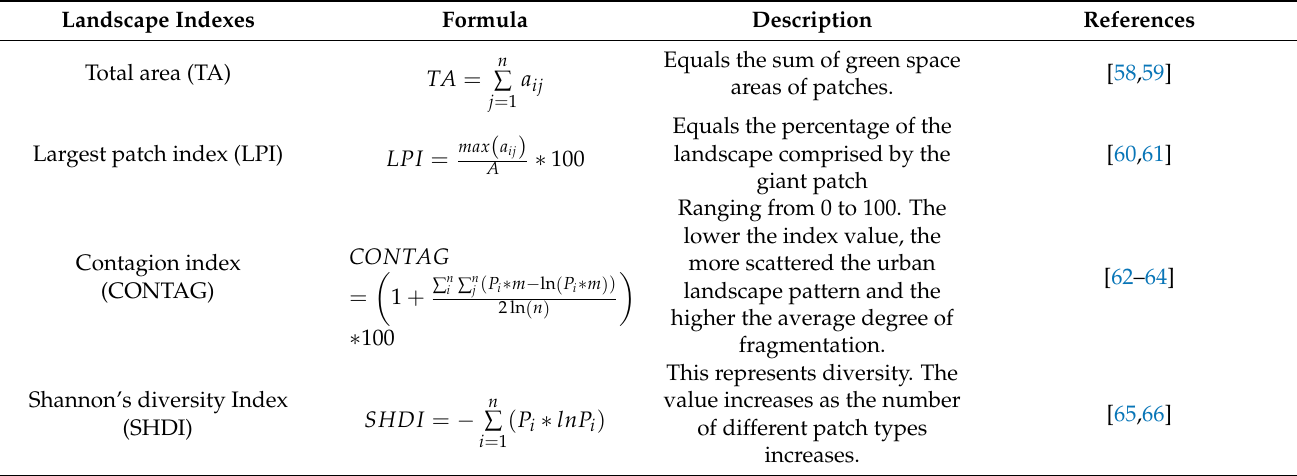
Table 1. Formula and explanations of landscape